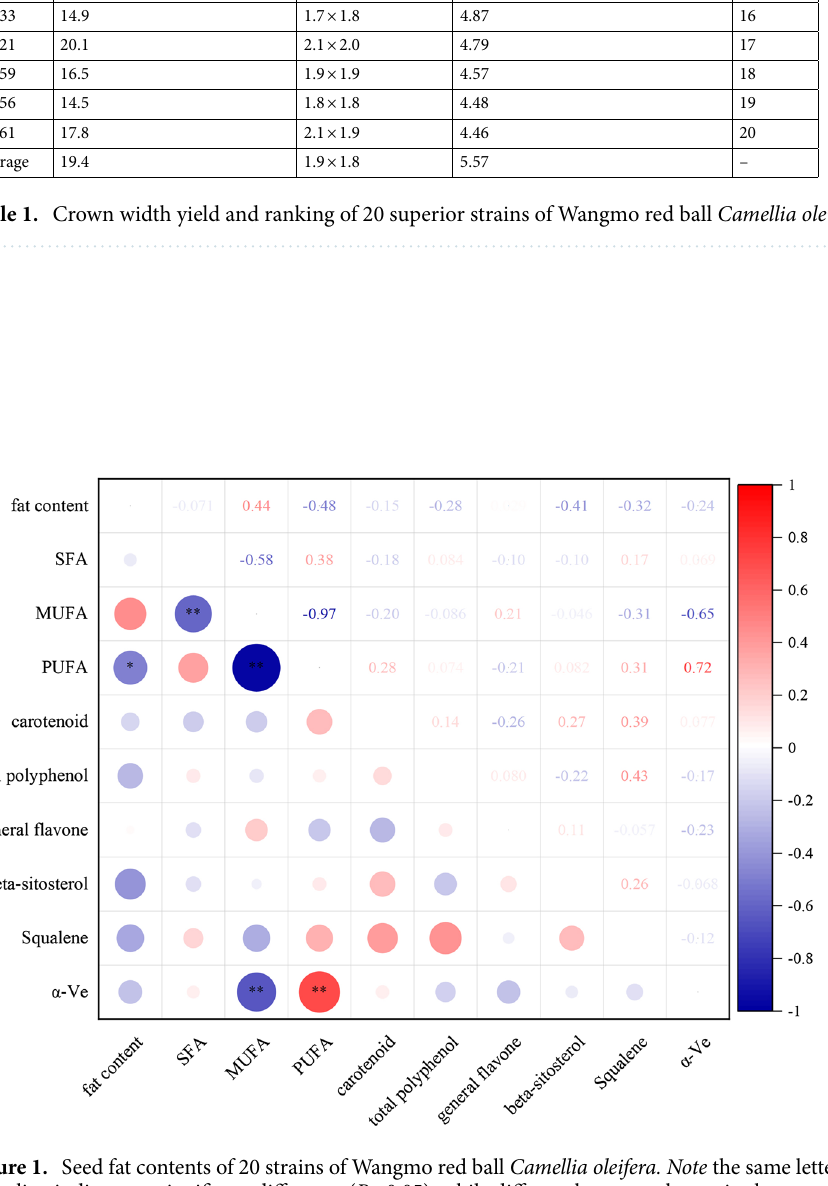
Figure 1. Seed fat contents of 20 strains of Wangmo red ball Camellia oleifera. Note the same letters in the same line indicate no significant difference ( P > 0.05), while different lowercase letters in the same line indicate a significant difference ( P <